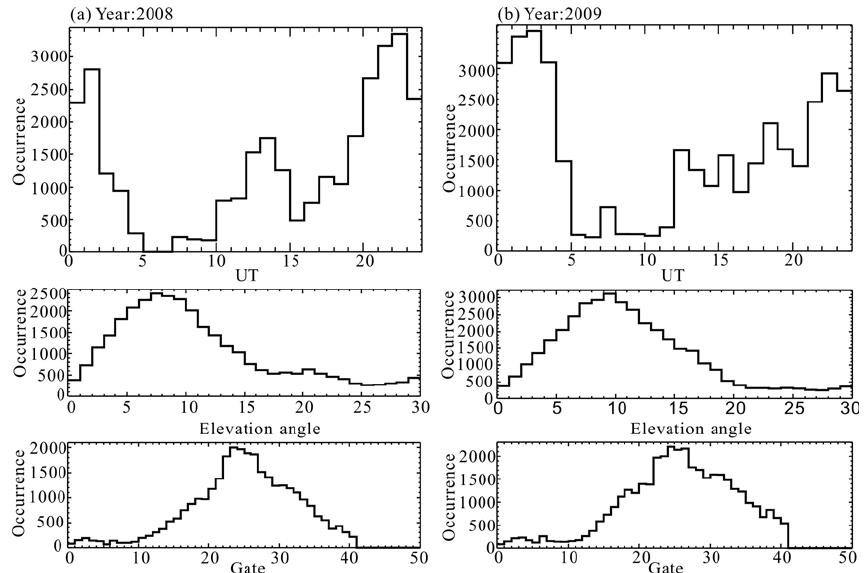
Figure 4 574 Fig. 4. Statistical histograms of universal time (UT), elevation angle and gate for Hankasalmi beam 9 common mode data in (a) 2008 and